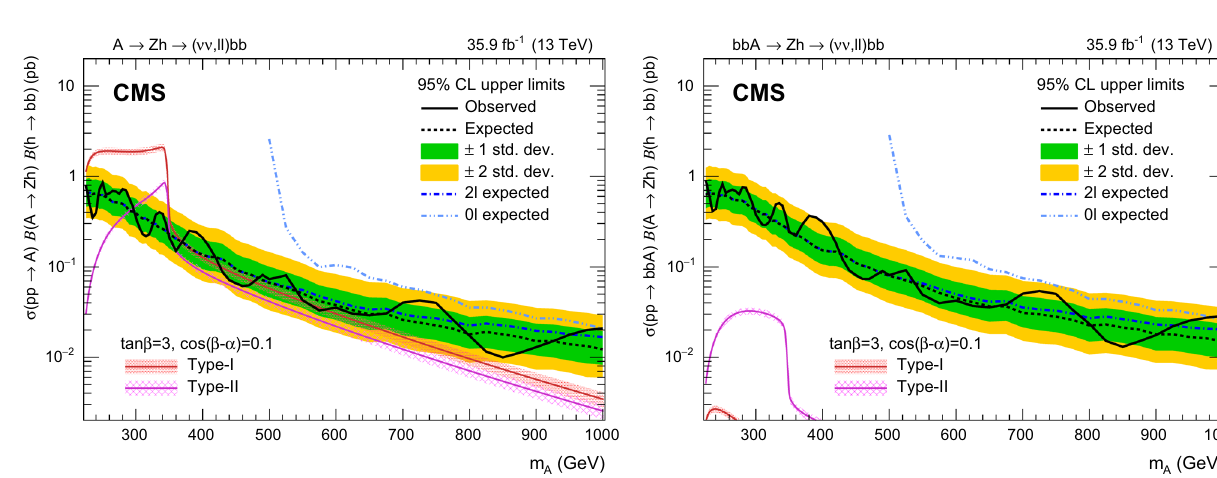
Fig. 5 Observed (solid black) and expected (dotted black) 95% CL upper limits on σ A B ( A → Zh ) B ( h → b ¯ b ) for an A boson produced via gluon–gluon fusion (left) and in association with b quarks (right) as a function of m A . The blue dashed lines represent the expected limits of the 0 (cid:5) and 2 (cid:5) categories separately. The red and magenta solid curves